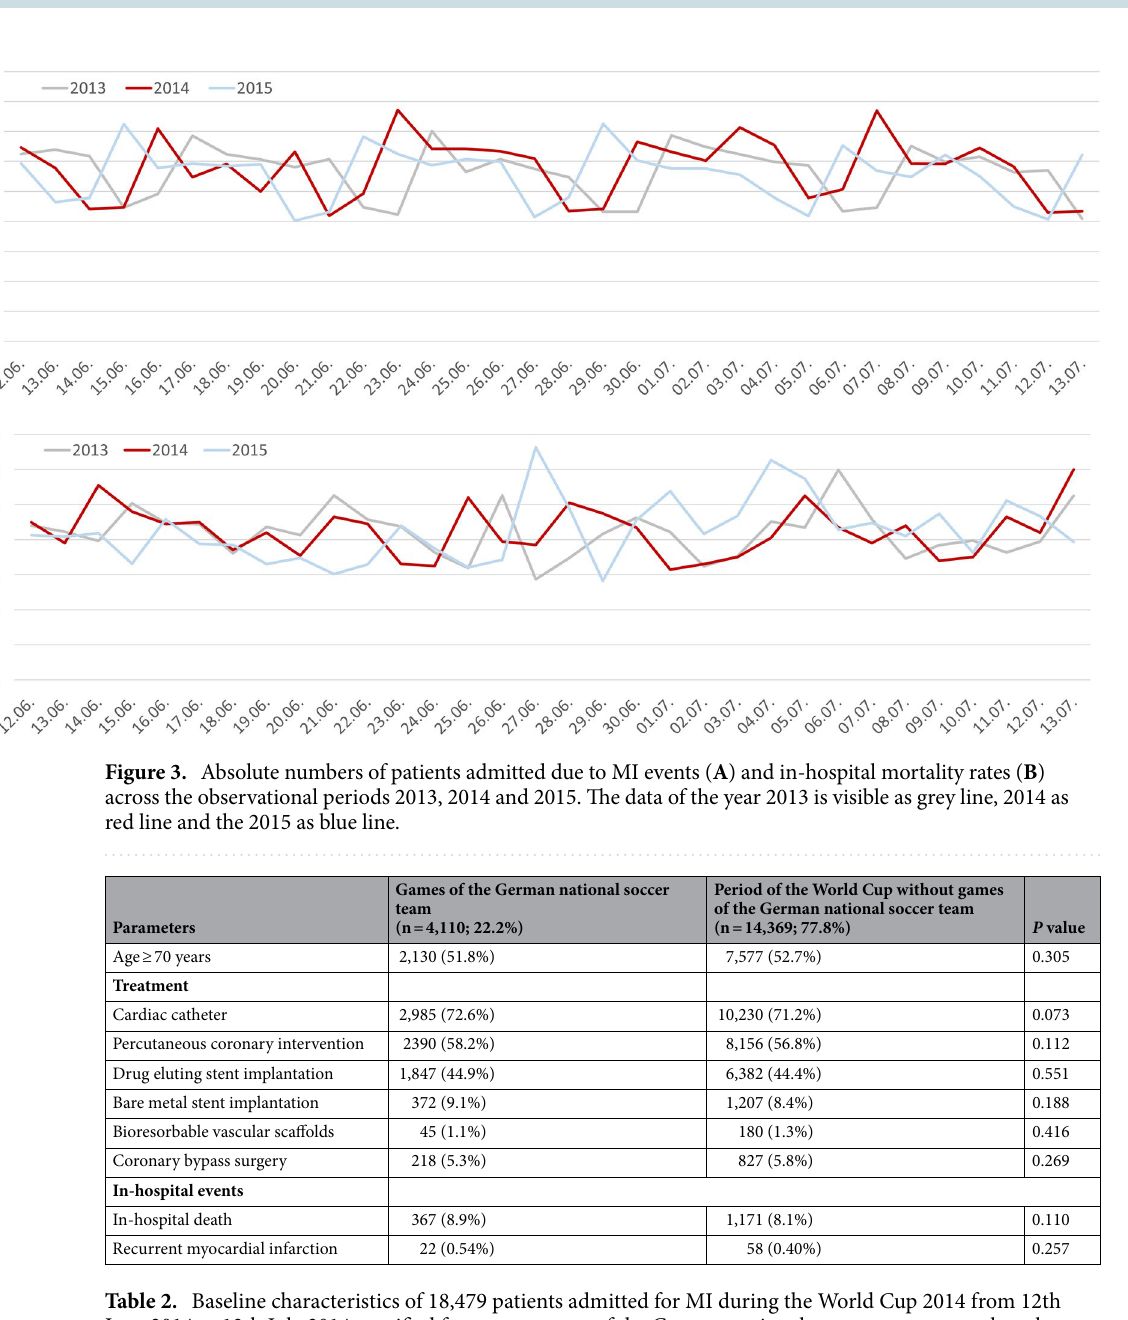
Table 2. Baseline characteristics of 18,479 patients admitted for MI during the World Cup 2014 from 12th June 2014 to 13th July 2014 stratified for soccer games of the German national soccer team versus the other days of world